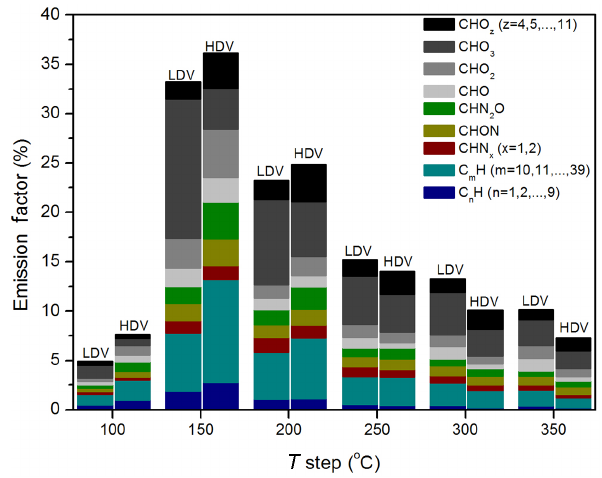
Figure 6. Fraction of total average emission (in %) divided into groups containing CH, CHO, CHON, and CHN, considering dif- ferent numbers of carbon and oxygen atoms in the compounds for LDVs and HDVs at each temperature